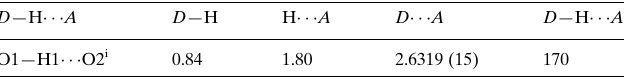
Hydrogen-bond geometry (A˚ , (cid:3)